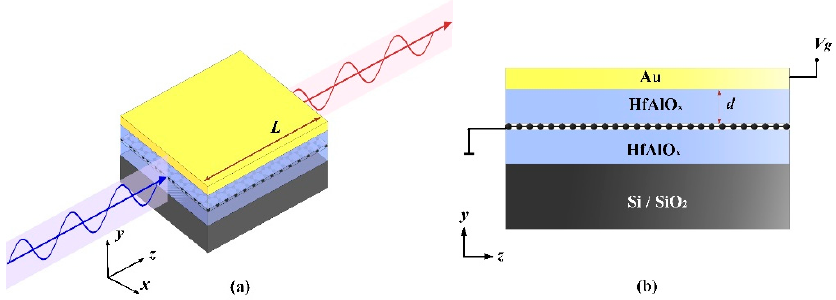
Figure 1. Schematic illustration of the proposed structure: ( a ) 3D layout; ( b ) cross-section.